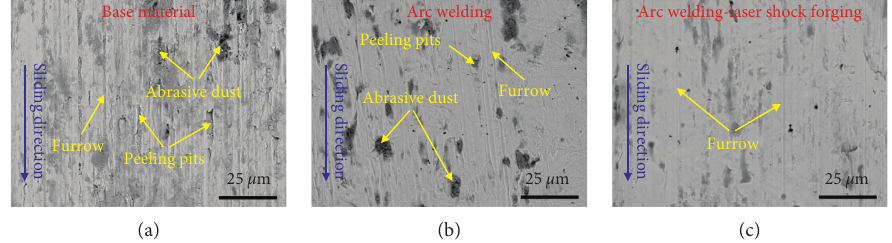
Figure 12: SEM images of the worn surface of the sample: (a) BM, (b) AW cladded layer, and (c) AW-LSF cladded